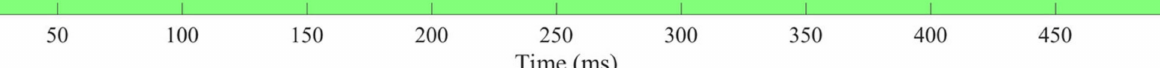
Figure 4. Correlations between SD RTs and ERSPs after the presentation of the Go stimulus. Negative correlation coefficients are shown in cool colors. Darker colors correspond to stronger correlations (see vertical bars for exact values). Time- frequency areas with non-significant correlation coefficients are shown in green. The moment when the stimulus was presented is represented by 0. Heads at the top of the figure display the distribution of significant correlation coefficients in the maps of electrodes. n =